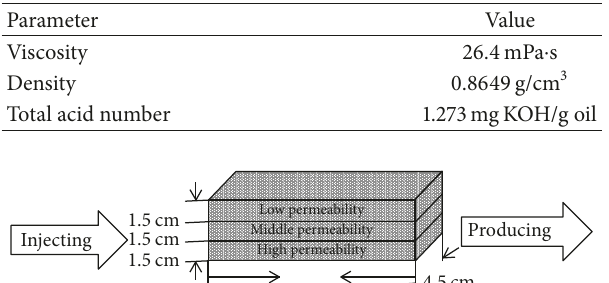
Table 1: Property of Dagang crude oil (at 53 ∘ C).